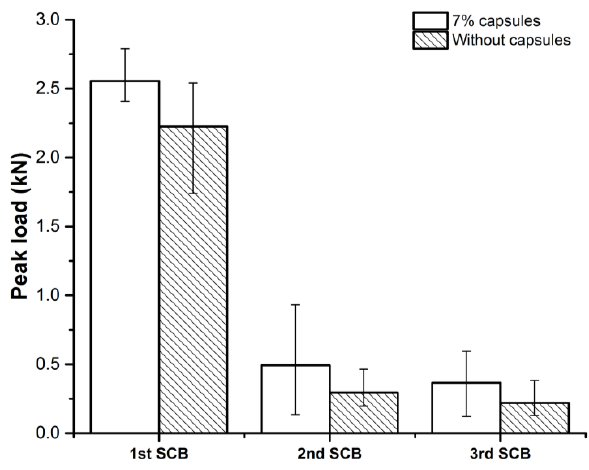
Figure 11. Peak load of SCB specimens.